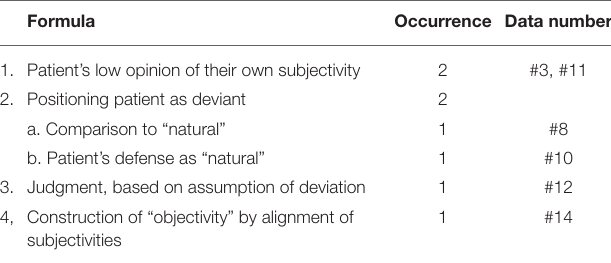
TABLE 7 | Observed contexts and formulae related to disruption and intruding on a patient’s